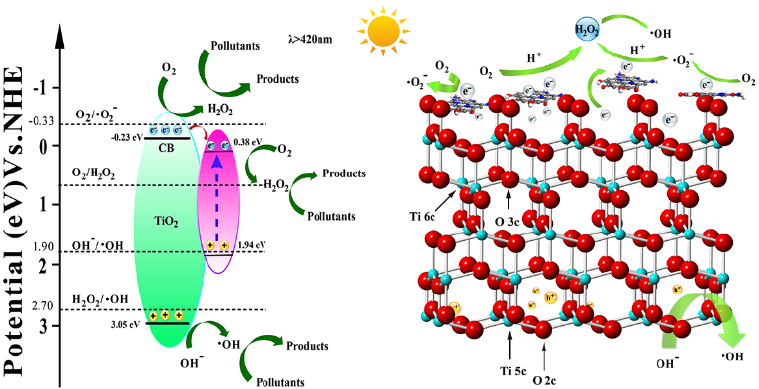
Scheme 1. Schematic illustration of the proposed band alignment and interfacial electron